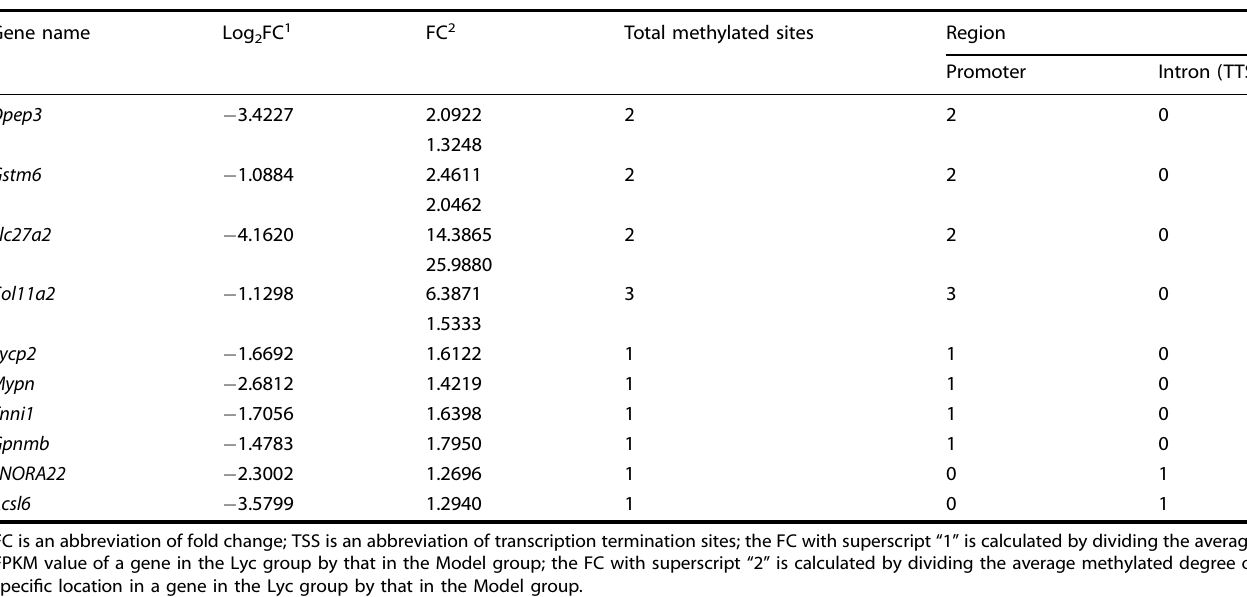
Table 2. Differential genes ( P < 0.05 in both transcriptome and methylome) with hypermethylation and suppressed expression after the intervention of LBP.